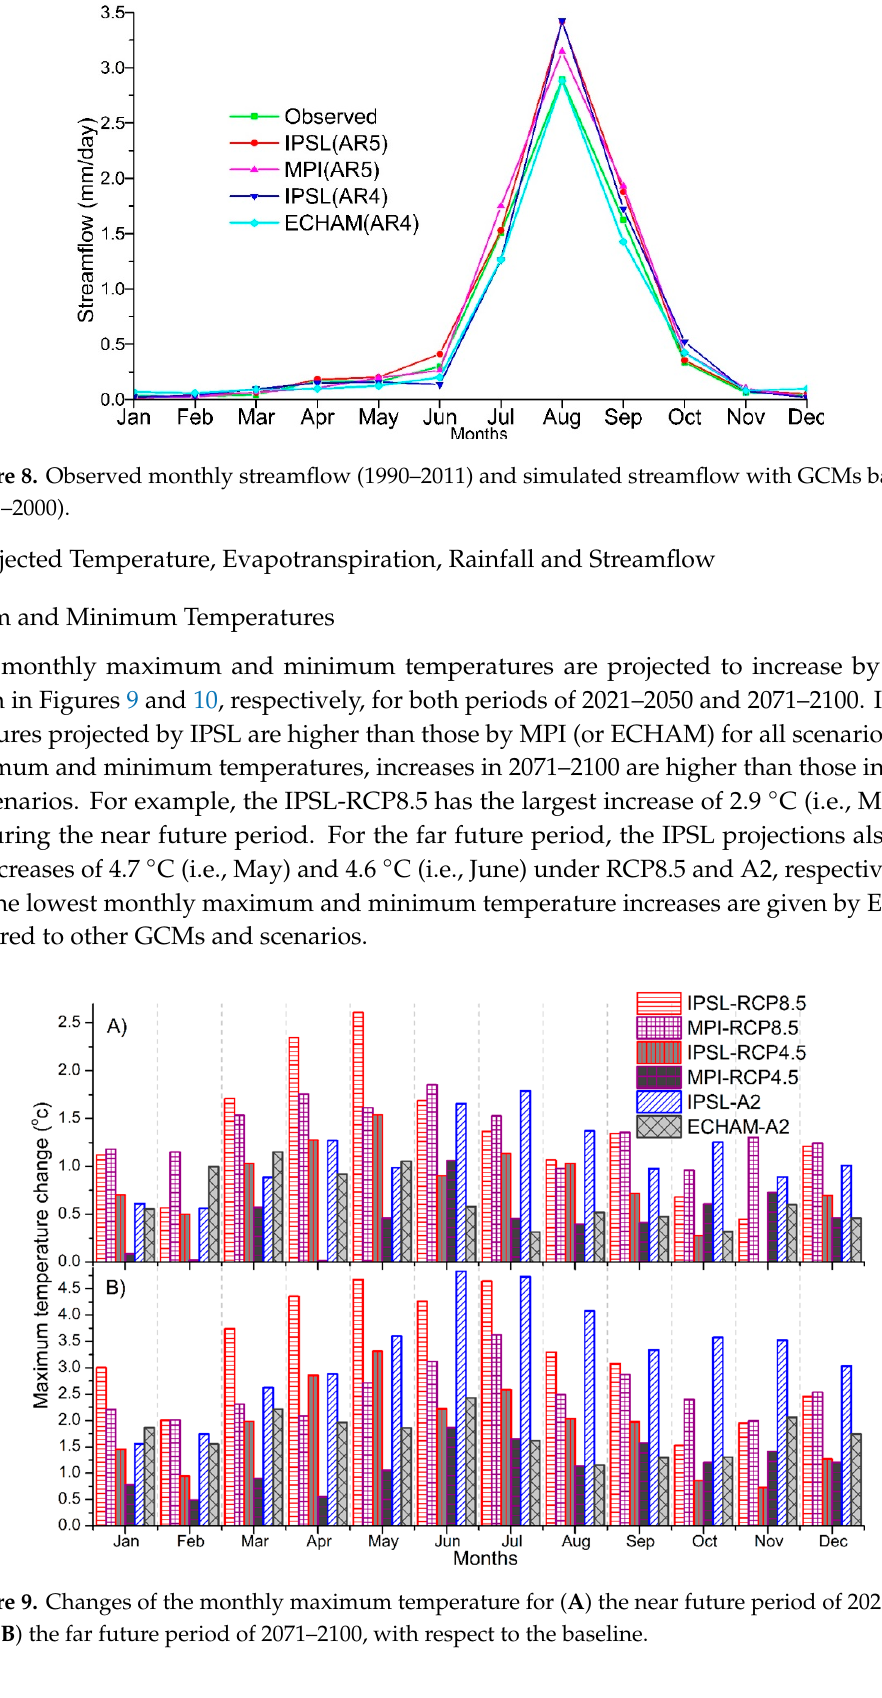
Figure 10. Changes of the monthly minimum temperature for ( A ) the near future period of 2021–2050 and ( B ) the far future period of 2071–2100, with respect to the baseline. Rainfall Rainfall projections are calculated as percentage changes with reference to the GCMs baseline and present separately for annual and seasonal scales as shown in Figure 11. All GCMs scenarios show larger rainfall percentage changes in the 2071–2100 period. Projections with the IPSL-RCP8.5 has the most significant increases in annual and major rainy season rainfall for both time periods. For example, the largest changes of 57% and 77% are projected by the IPSL-RCP8.5 for 2021–2050 and 2071–2100, respectively. Annual rainfall and the major rainy season are expected to increase, except the ECHAM-A2 scenario, but our values are higher than the projected change of 9% for the Awash basin, with 10 GCMs [36], and 17.2% (RCP4.5)–34.4% (RCP8.5) for the Keleta subbasin, with 20 GCMs